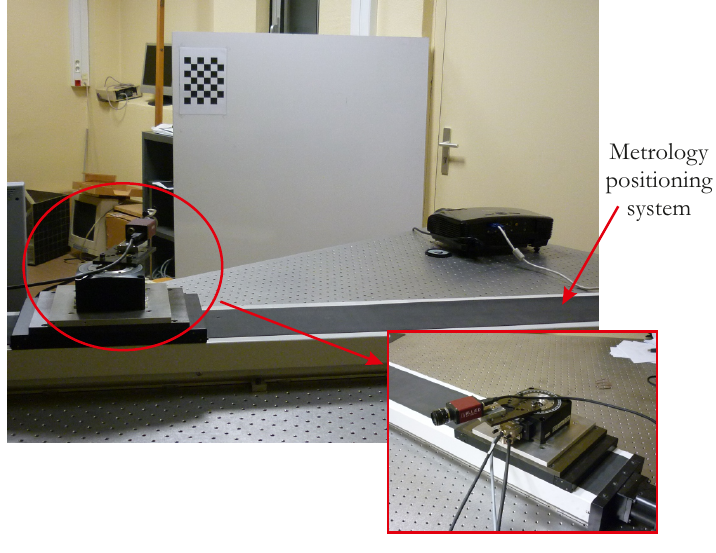
Figure 8. System configuration.